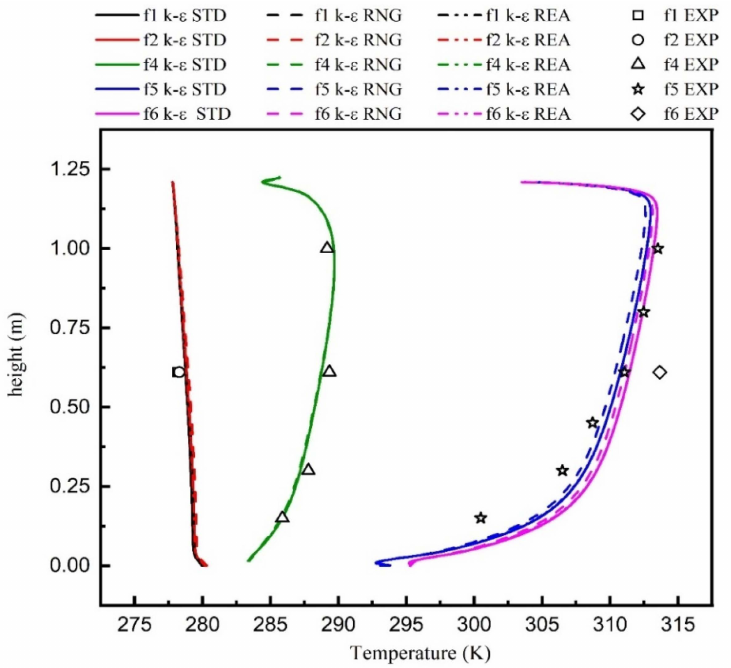
Figure 11. Experimental and numerical temperatures for the three glazings, according to k- ε models with an enhanced wall